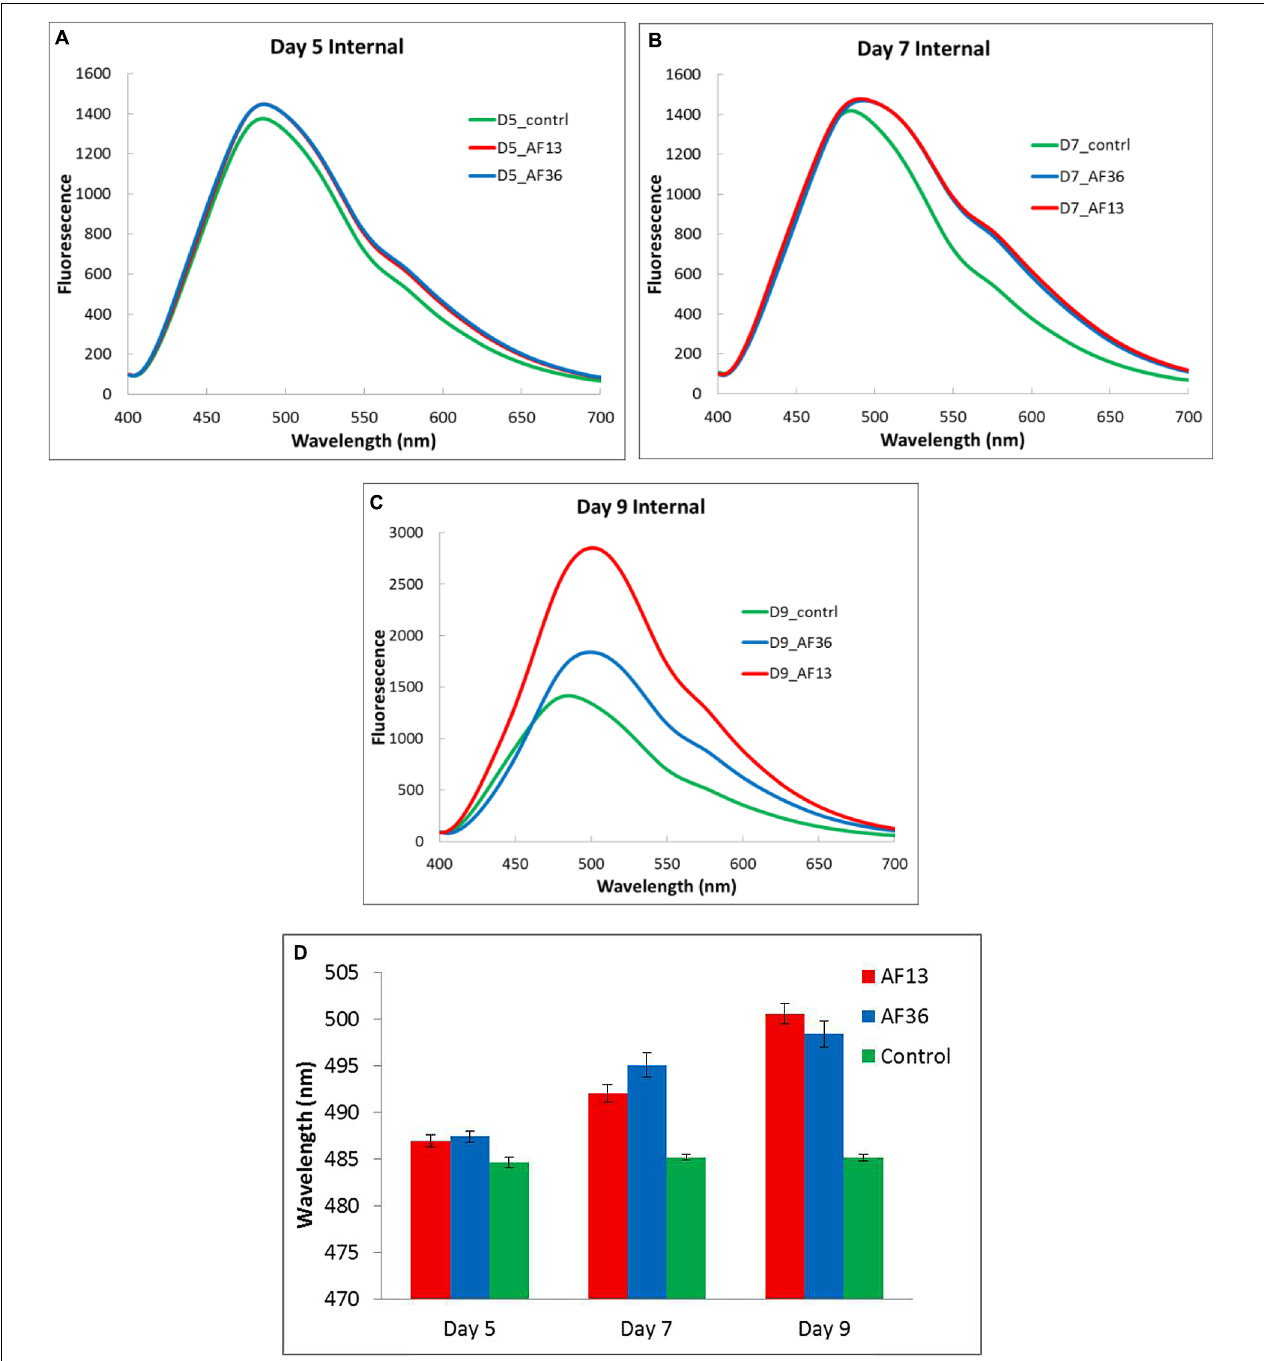
FIGURE 4 | Internal fluorescence spectral means (A–C) and analysis of variance between fluorescence peak means ± SE (D) , from cross-sections of maize kernels inoculated with toxigenic and atoxigenic strains of A. flavus (AF13 and AF36) at three time points over a 9 day period ( A -Day 5, B -Day 7, and C -Day 9), including